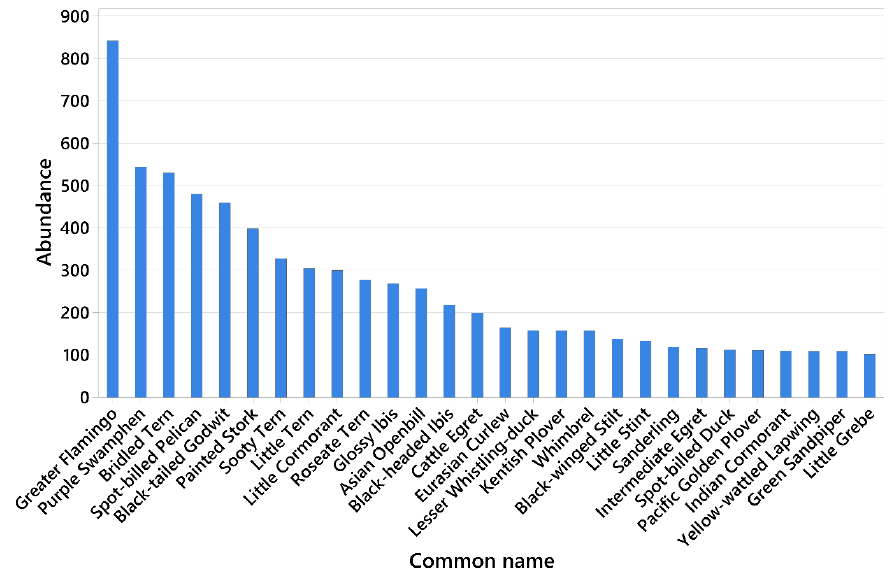
Figure 3. Abundance (number of records) of the most common waterbird species in the Sarasalai mangrove.